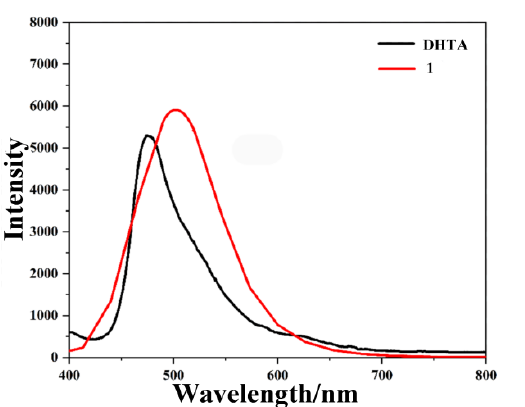
Figure 7. PXRD of complex 1 .